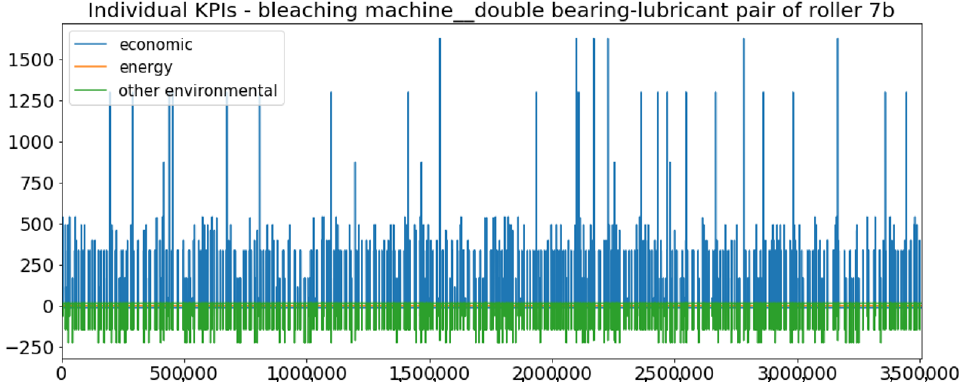
Figure 18. Individual KPI time series for the double bearing-lubricant pair of the bottom roller yielded from running the model with paired coated rollers for the bleaching machine (ZORLUTEKS). The simulation interval has the same length as for training (200